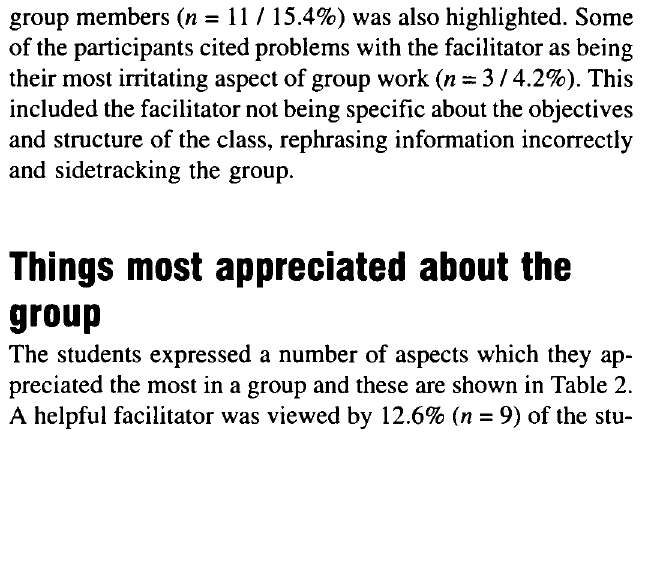
Table 3: Expected from the group ( n ^ 7 1 )